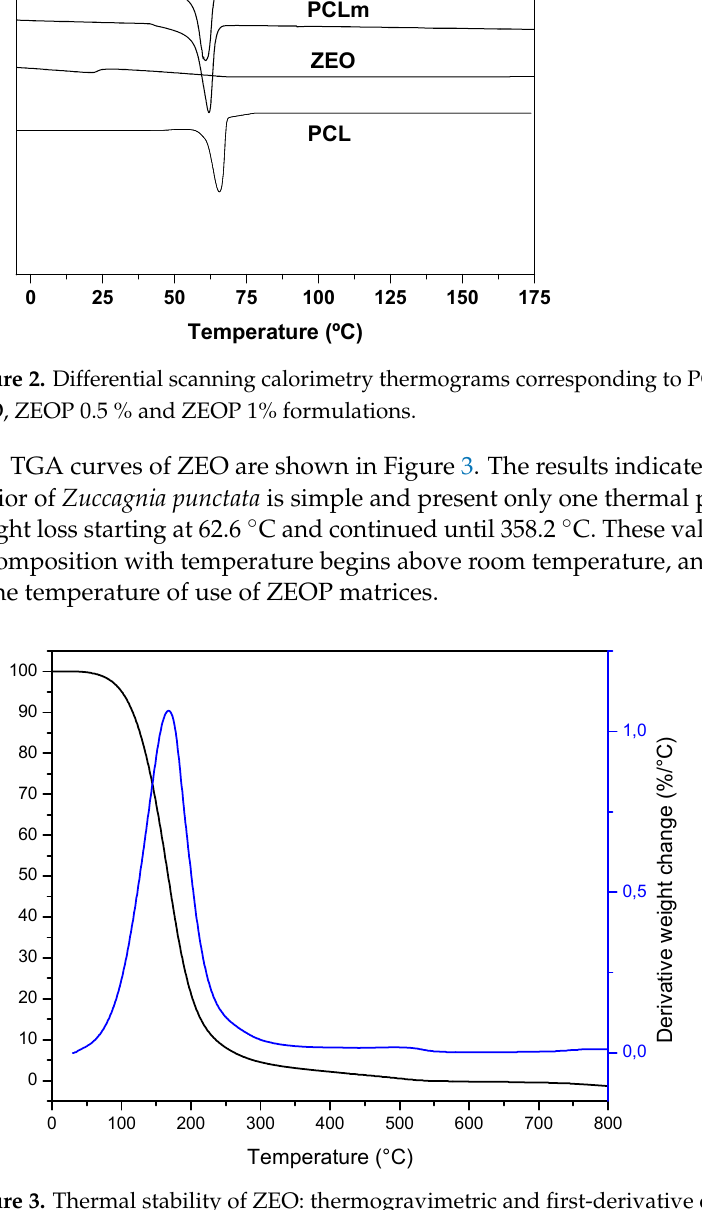
5 of 12 Figure 1. Morphological characterization, ( A ) Optical image of ZEOP 1% disc 10 mm, ( B ) SEM micrograph of ZEOP 1% (1000×). 2.3. Thermal Properties and Crystallinity The Figure 2 shows the DSC thermograms. PCL pellets exhibited a characteristic ther- mogram with a melting temperature of 65.6 °C and crystallinity of 59.3%. PCL matrices showed a decrease in the melting point (Tm = 62 °C) and slight increase in crystallinity (63.8%) which can be attributed to the matrix formation during solvent casting. The incor- poration of ZEO led to a decrease in Tm values with the increase in the oil content (ZEOP 0.5%, 61.4 °C and ZEOP 1%, 59.0 °C). This phenomenon agrees with the decrease in the crystallinity degree (ZEOP 0.5%, 61%, and ZEOP 1%, 59.6%), and it could be ascribed to the incorporation of oil, which makes difficult the crystallization process during the sol-